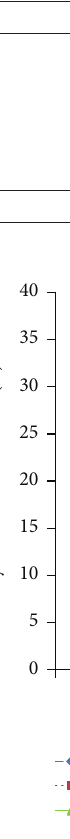
Figure 5: Thickness uniformity versus plating time at various electrode